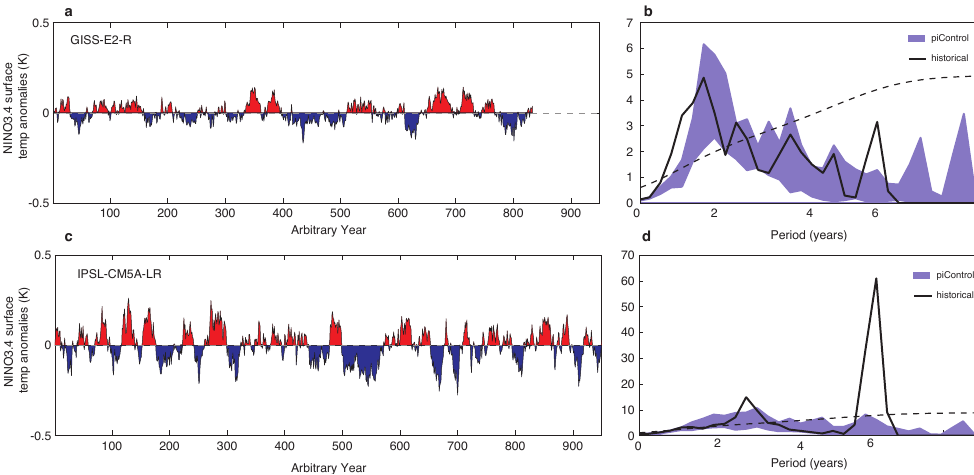
Figure 6. Running annual-mean surface temperature anomalies (K) over the NINO3.4 region (5 ◦ N–5 ◦ S, 170–120 ◦ W) for extended piCon- trol simulations conducted with GISS-E2-R (a) and IPSL-CM5A-LR (c) models. Red/blue shading highlights departures from each model’s long-term mean. Running means were calculated using a 240-month triangle smoother. Control simulations are spun up to quasi-equilibrium and run for ideally >500 years, providing an arbitrary time series of model internal variability. Global mean NINO3.4 power spectrum (K 2 /unit frequency, black), relative to the red-noise (AR(1)) benchmark (dashed) for GISS-E2-R (b) and IPSL-CM5A-LR (d)